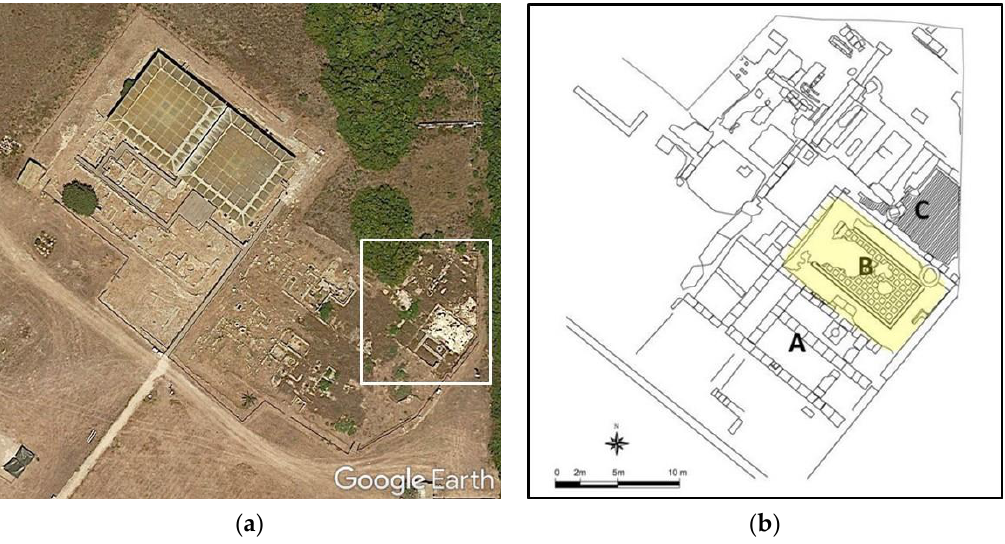
4 of 18 Figure 1. Archaeological Park of “Lilibeo” inside the modern city of Marsala (Italy) (from Google Earth© ). The urban ancient city plan was divided by primary ( plateiai ) and secondary streets ( stenopoi ) organized along an orthogonal grid. The length of the blocks is not yet known, but they measured about 30 m on the short side, as found in the northeast sector of the